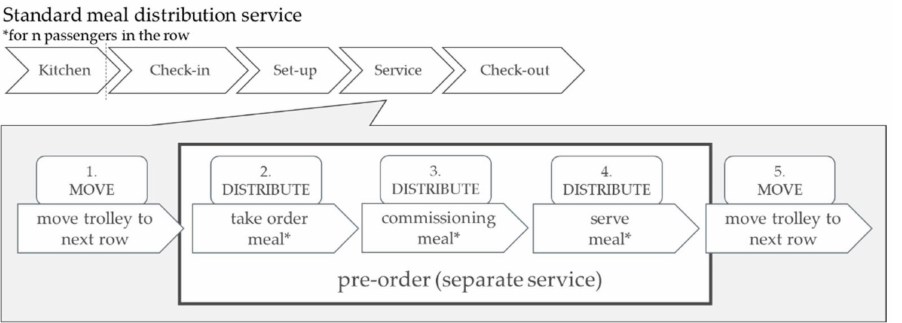
Figure 15. Process steps of a standard meal distribution service to a passenger.